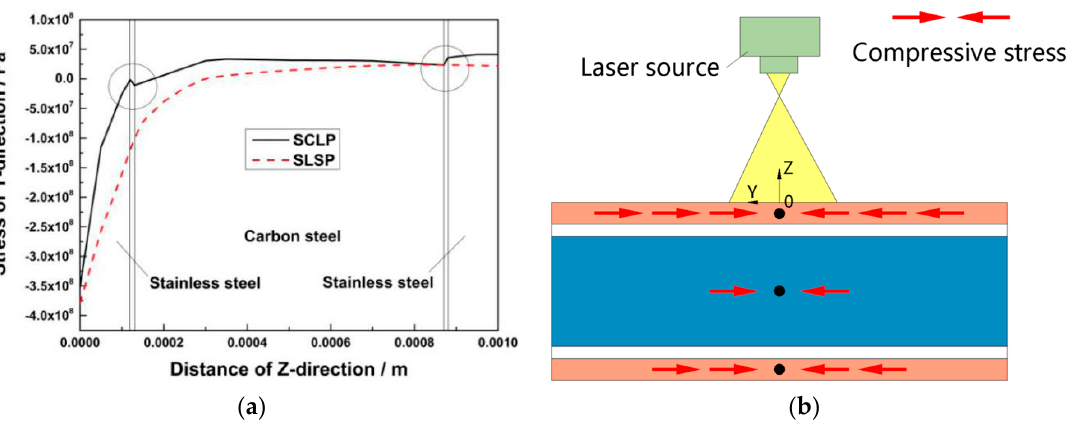
Figure 8. Y-direction stress analysis at 3.752 s: ( a ) Comparison of stress curves of the SCLP and the SLSP; ( b ) schematic diagram of stress distribution of the SCLP.